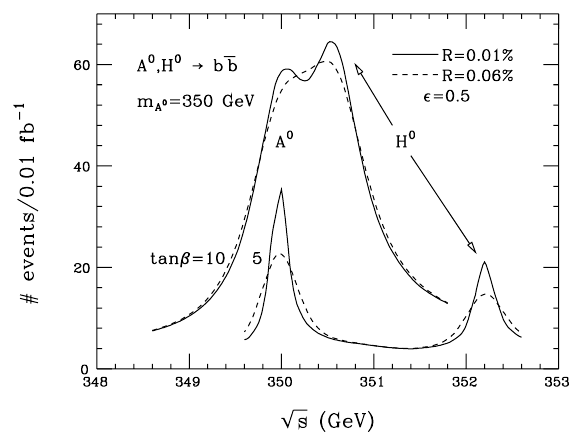
FIG. 11. Separation of A and H signals for tan @ (cid:4) 5 and 10. From Ref.